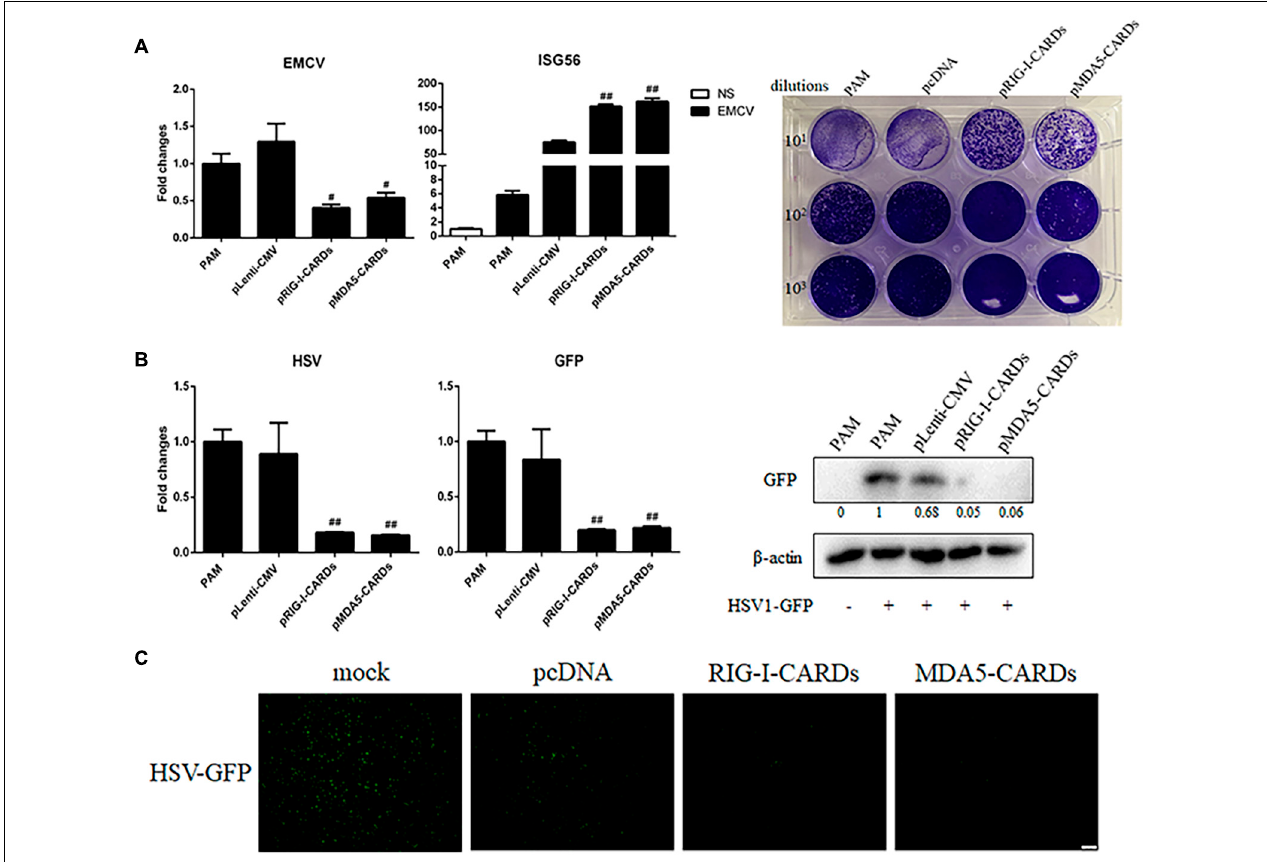
FIGURE 4 | The anti-EMCV and HSV-1 activity of porcine RIG-I and MDA5 CARDs. (A) PAMs grown on 24-well plates (3 × 10 5 cells/well) were transfected with the indicated CARDs expression plasmids and control vectors (0.5 µ g each) using TransIT-LT1 Transfection Reagent for 24 h. Then the cells were infected with EMCV virus at MOI of 0.01 for 12 h and analyzed by RT-qPCR for virus replication, downstream gene expression and by plaque assay for observation of plaque formation in Vero cells at 24 h post infection. (B,C) PAMs grown on 24-well plate (3 × 10 5 cells/well) were transfected with CARDs expression plasmids and pLenti-CMV vector (0.5 µ g each) using TransIT-LT1 Transfection Reagent for 24 h. Then the cells were infected with HSV-1-GFP virus at MOI of 0.01 for 12 h. The cells samples were analyzed by RT-qPCR for virus replication and downstream gene expressions as indicated or detected by Western-blotting with anti-GFP mAb (B) . The GFP signals were visualized under microscope (C) . # p < 0.05, ## p < 0.01 vs. vector